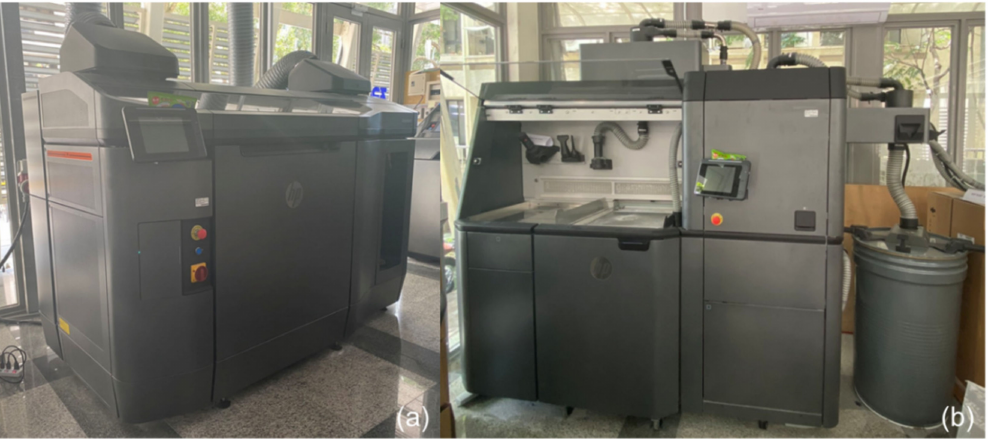
Figure 7. ( a ) HP MJF 4200 printer, and ( b ) HP MJF Post-processing station.